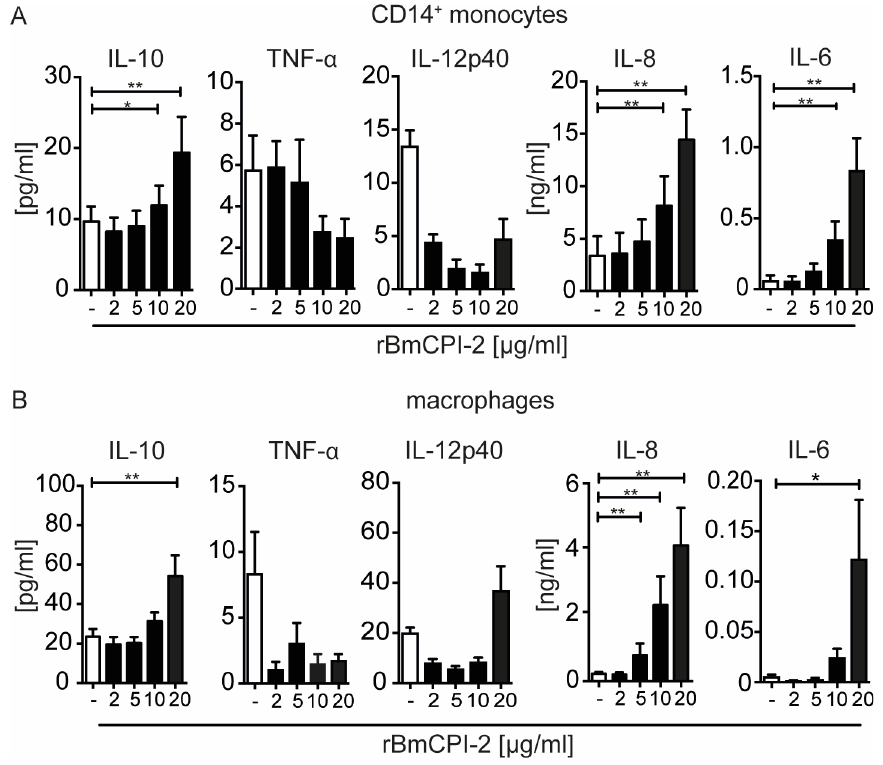
Fig 1. Brugia malayi cystatin-2 (rBmCPI-2) induces IL-10, IL-8 and IL-6 in human monocytes and macrophages. Human monocytes (A) and macrophages (B) were stimulatedwith different concentrations [ μ g/ml] of recombinant BmCPI-2 for 24h. Cytokines in the supernatant were detected by ELISA. Data are from 12 donorsand shown as mean ± SEM. Statistical analysiswas done using the Wilcoxon